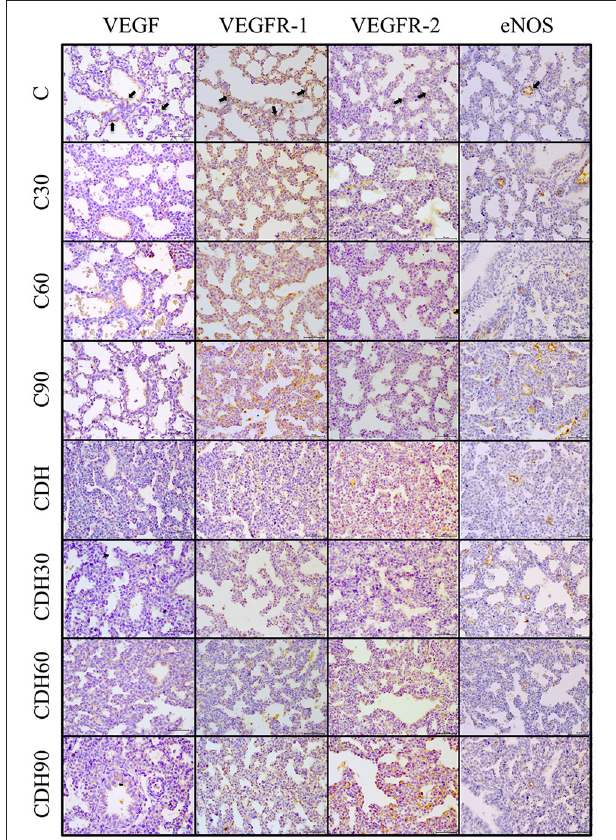
FIGURE 3 | Positive immunostaining in the different groups. Representative lung sections of immunohistochemical staining for VEGF, VEGFR-1/2 and eNOS. Black arrows on the top figures show the immunostaining pattern from each marker. C, control; C30, control ventilated for 30min; C60, control ventilated for 60min; C90, control ventilated for 90min; CDH, congenital diaphragmatic hernia; CDH30, CDH ventilated for 30min; CDH60, CDH ventilated for 60 minu; CDH90, CDH ventilated for 90min. Magnification = × 400; bar = 50 µ